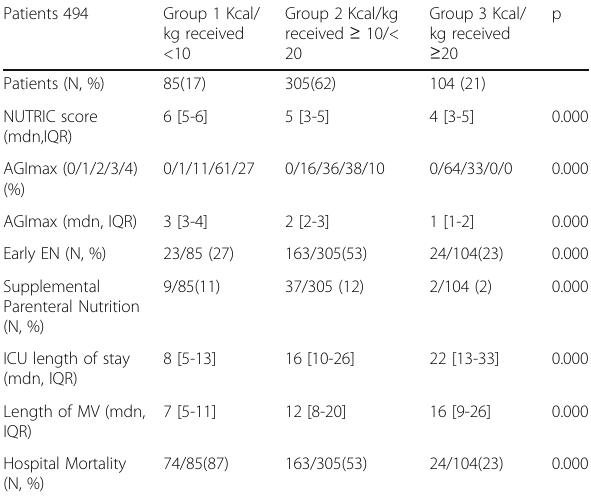
Table 2 (abstract 0042). Nutritional and outcome variables of the 3 subgroups of patients on vasopressors Patients 494